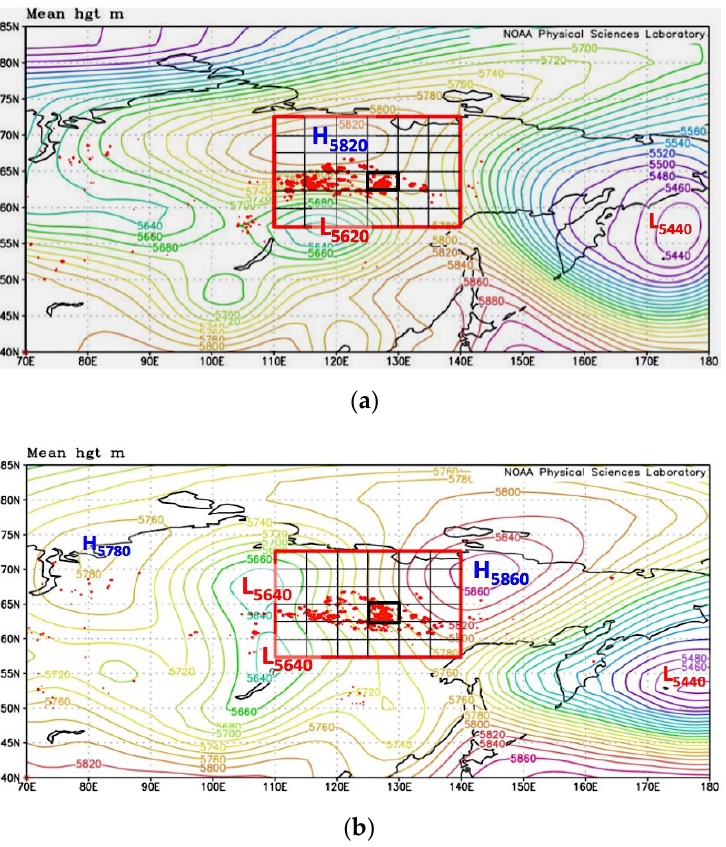
Figure 5. ( a ) Weather map on 2 August. See captions for Figure 4, ( b ) weather map on 7 August. See captions for Figure